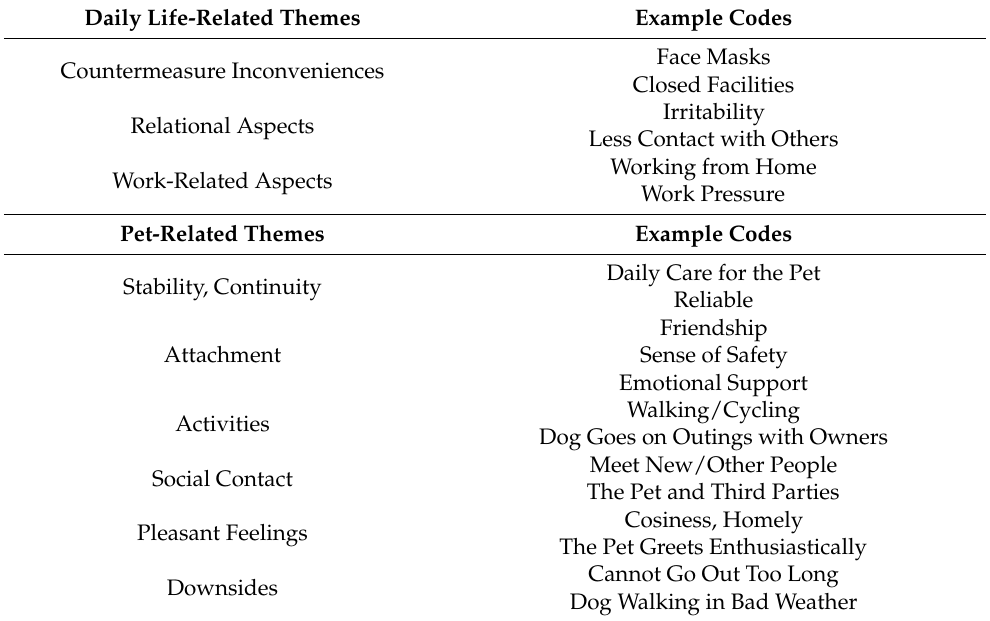
Table 2. Themes and Example Codes retrieved from interviews about the pandemic and the role of